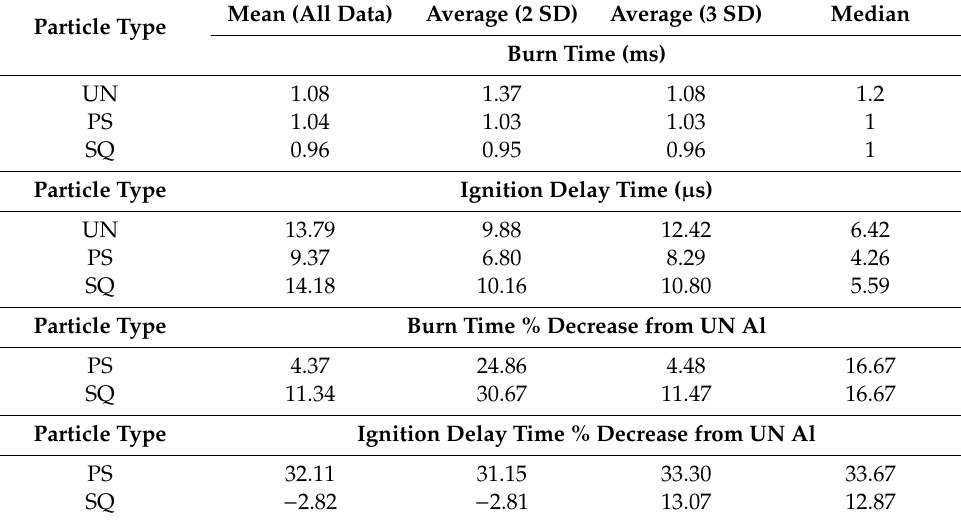
Table 1. Average and median burn time and ignition delay values within di ff erent standard deviation (SD) bounds (with % di ff erences from the UN particles).